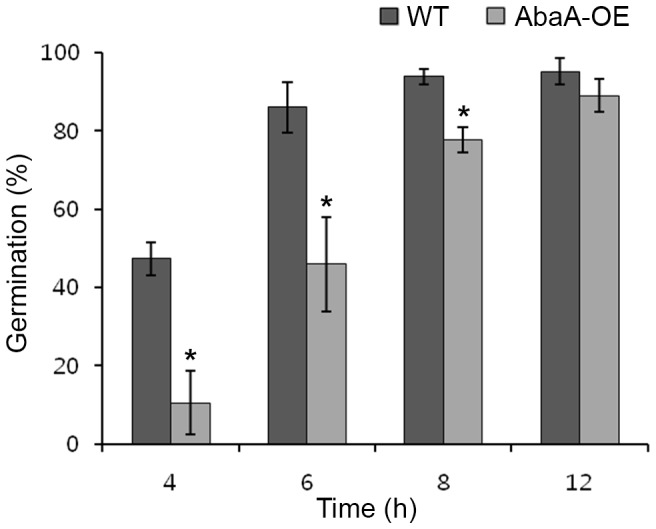
Germination rate of conidia.One ml of conidium suspension of each strain was incubated in 10 ml of complete medium (CM) at 25°C on a rotary shaker (150 rpm). One hundred spores were observed in each examination with light microscopy, and the number of conidia that germinated was counted. All data were obtained from three biological replicates. Asterisks indicate data that significantly differed (p<0.05) based on Tukey's test. WT, F. graminearum wild-type strain Z-3639; AbaA-OE, a transgenic strain with the abaA promoter replaced with the ef1α promoter.